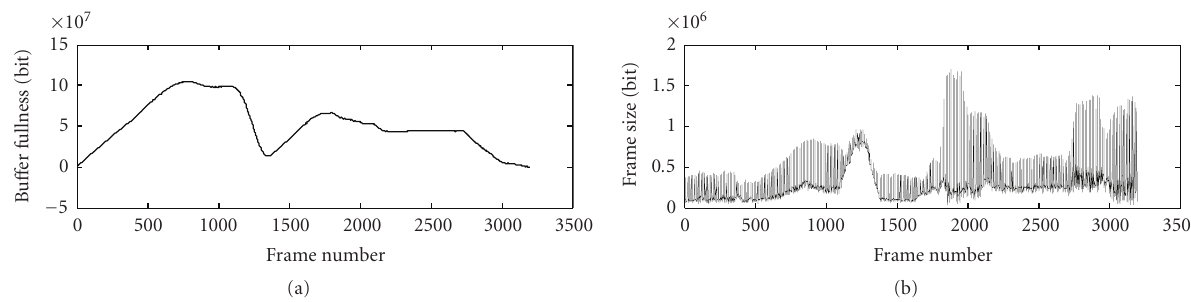
Figure 5: Bu ff er occupancy and frame size of “The Living Sea” video sequence encoded with a constant QP.